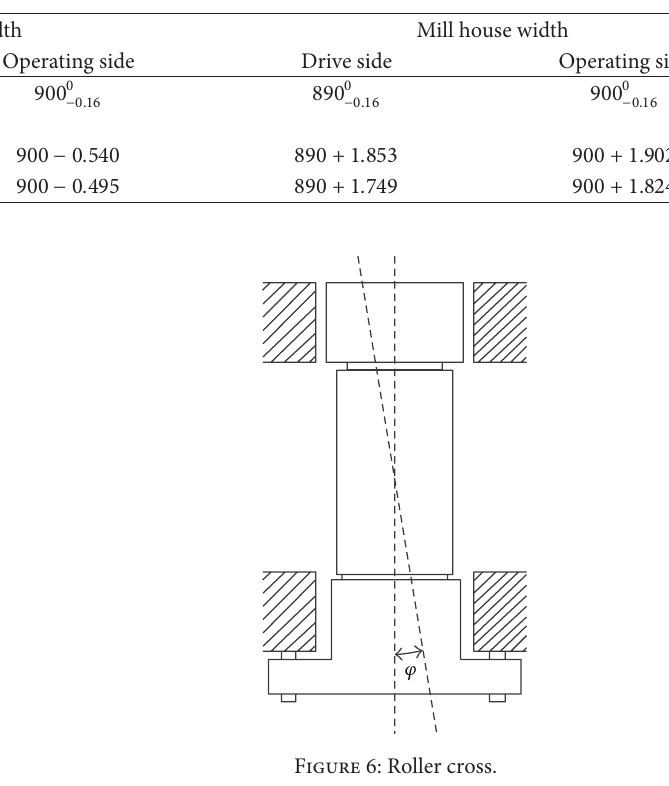
Table 1: Mill house and bearing seat clearance design value and measurements (unit: mm).